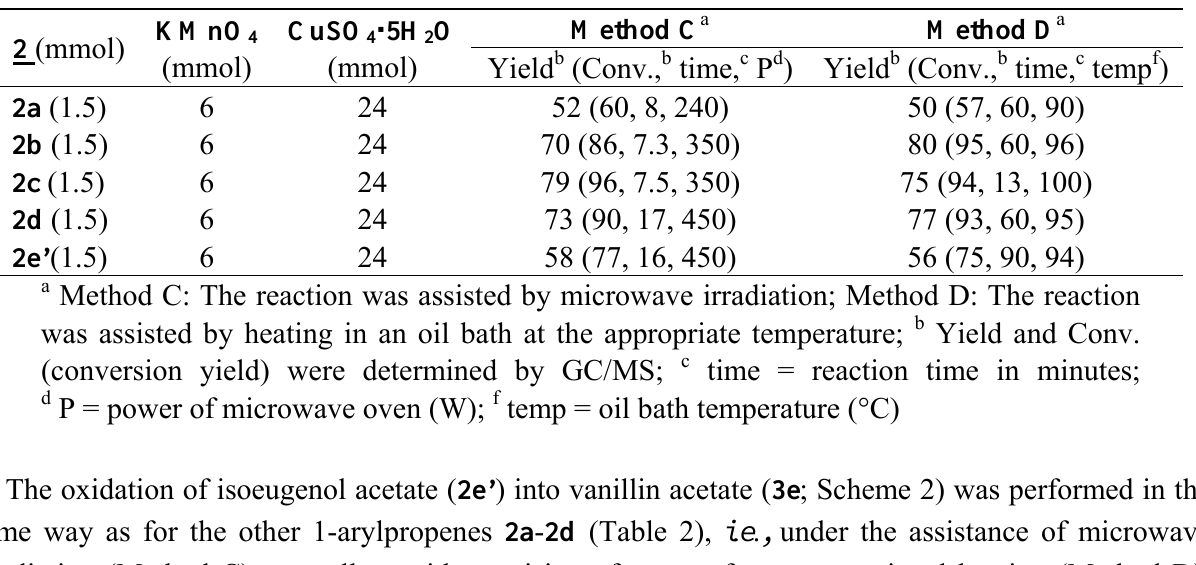
Table 2. Oxidation of 1-arylpropenes into corresponding